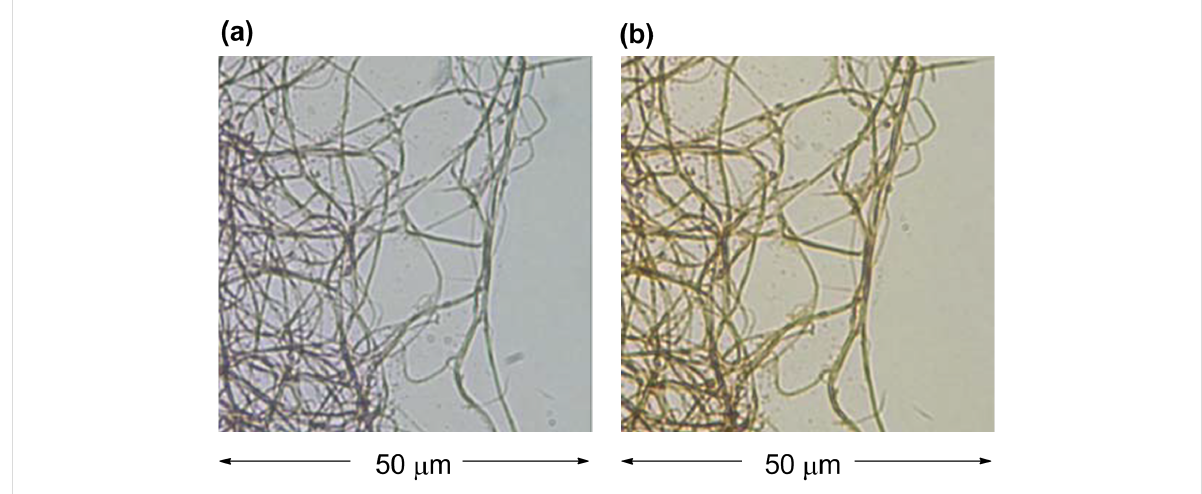
Figure 12: Optical micrographs (1000× magnified) of fibers, prepared from 30 in THF–H 2 O 1:1, on a glass plate at 23 °C. (a) Before iodine doping. (b) After iodine doping (3 min). Reprinted with permission from [26]. Copyright 2010 Royal Society of Chemistry.